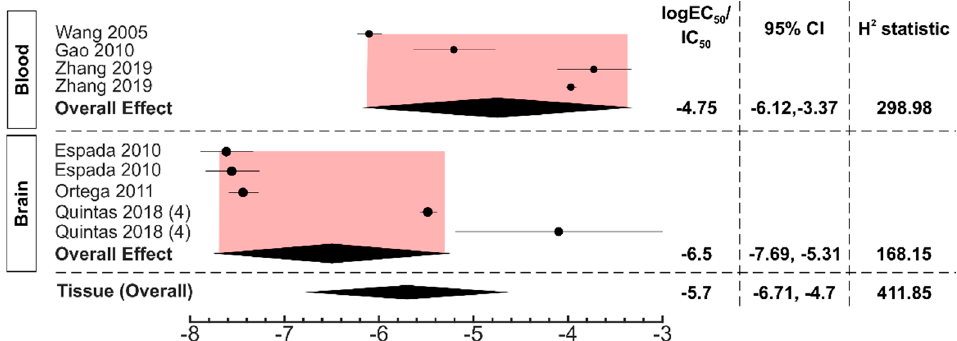
Figure 7. Subgroup analysis for endogenous P2Y13 responses in tissues. The forest plot represents the log 10 EC 50 values in the blood and brain to generate a P2Y13-mediated functional response. The black diamonds and the pink shaded region represent the overall effect size and the 95% confidence interval. All the studies were of sample size, n = 3, unless otherwise stated in parentheses.